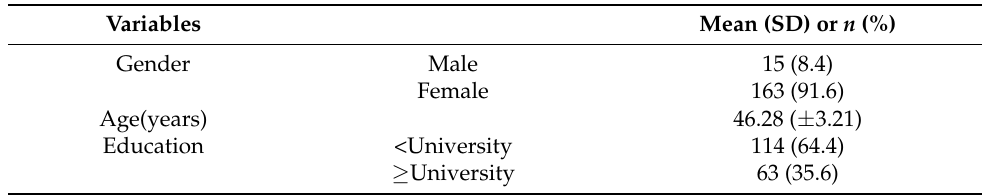
Table 1. Characteristics of the participants ( n = 178).